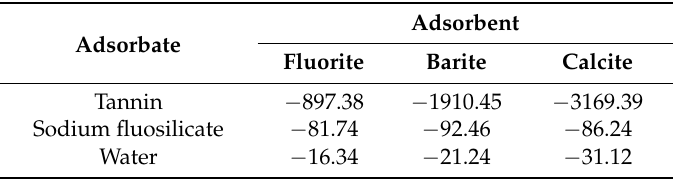
Table 4. A comparison of computed interaction energies (kcal/mol) of adsorbate molecules on mineral